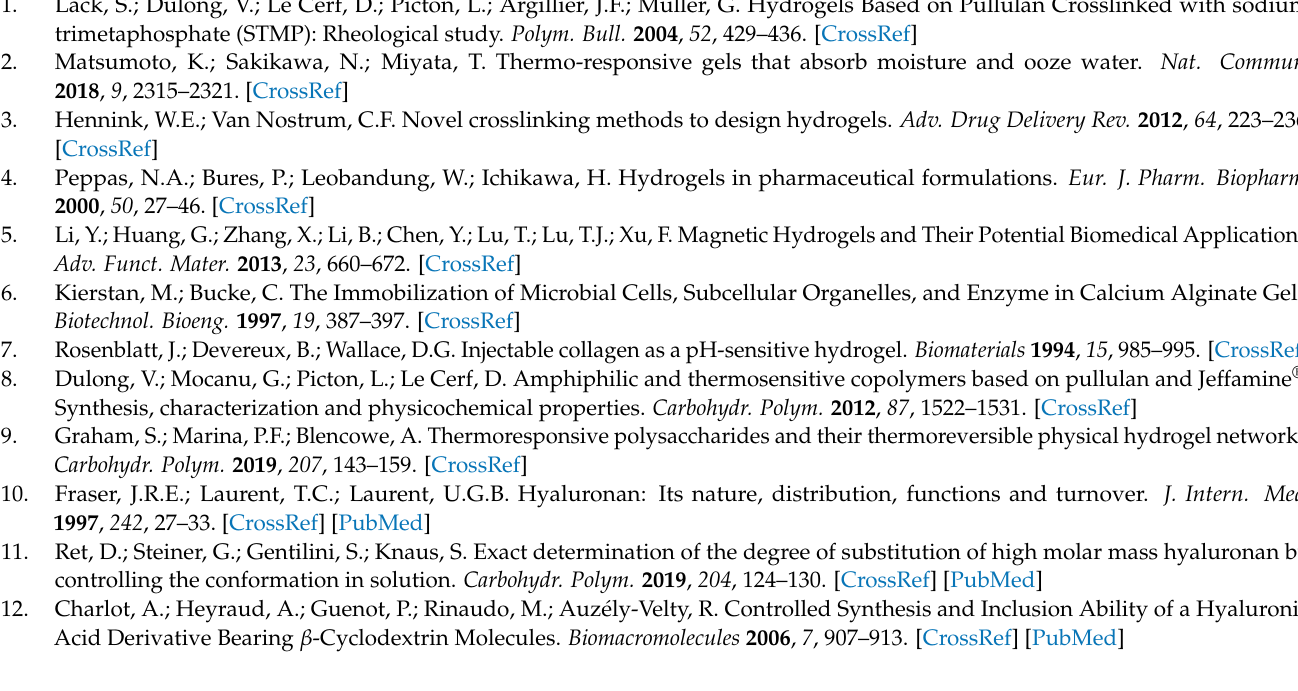
Figure S4: Rheological profile of HA 1200 - g (EDC) -M2005-4.5% at 1 wt% in water (with cooling ramp), and Figure S5: Rheological profile of HA 140 - g (T3P) -M2005-8.3% at 2 wt% in water (with cooling